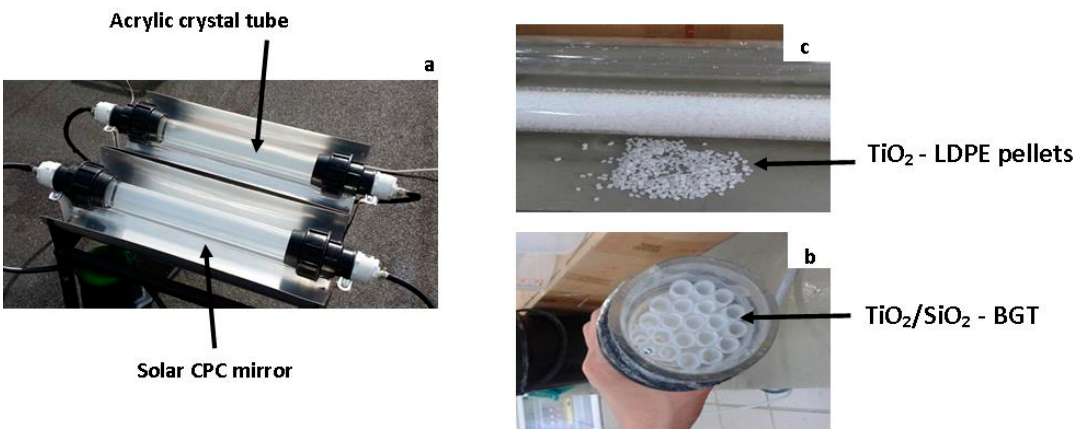
Figure 1. Photoreactor: ( a ) solar compound parabolic collector (CPC) reactor; ( b ) TiO 2 /SiO 2 ‐ borosilicate glass tubes (BGT); and ( c ) TiO 2 ‐ low density polyethylene (LDPE) pellets. glass tubes (BGT); and ( c ) TiO 2 -low density polyethylene (LDPE)